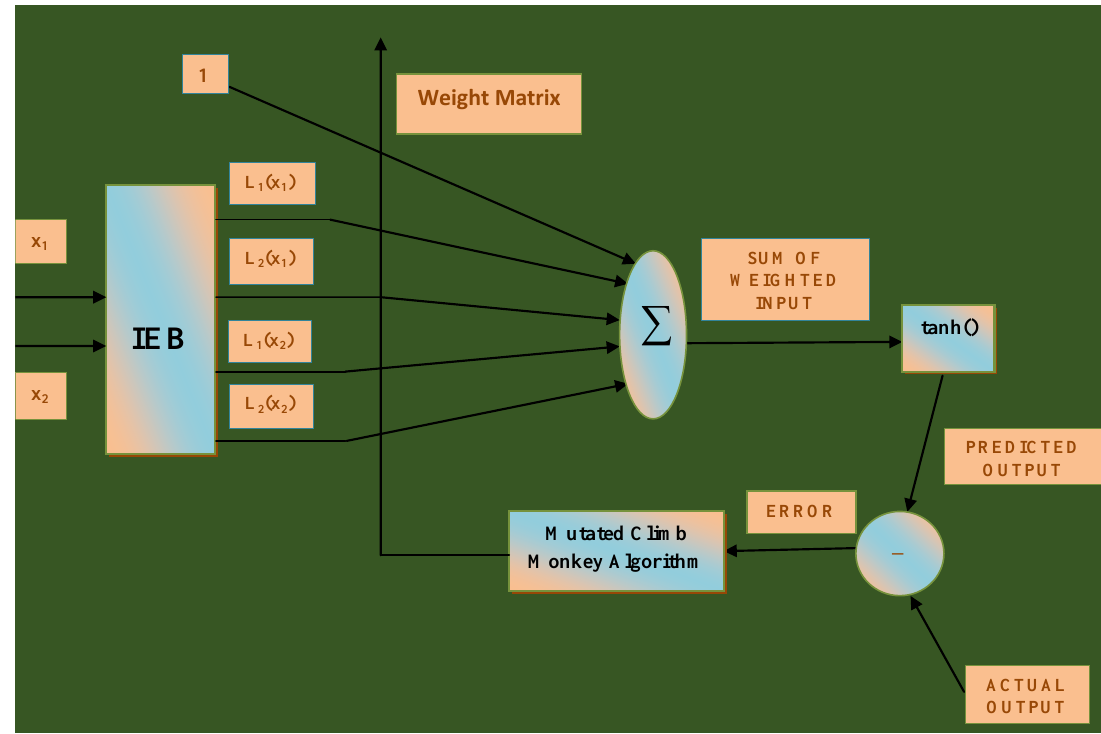
Figure 1. Training of the Legendre polynomials-based neural network using mutated climb monkey algorithm.